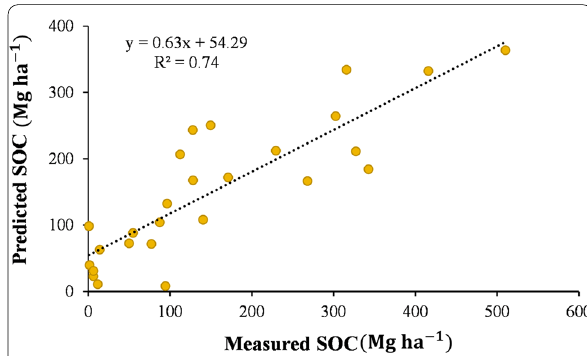
Fig. 4 Obtained relationship between measured SOC stocks and interpolation model-based SOC